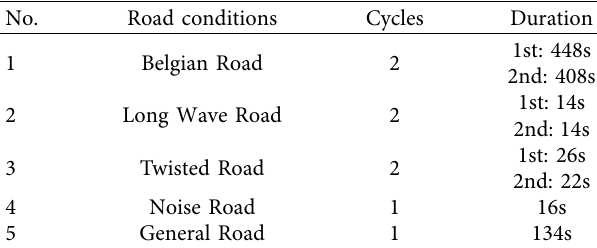
Table 2: The road conditions, duration, and cycles of the test road.